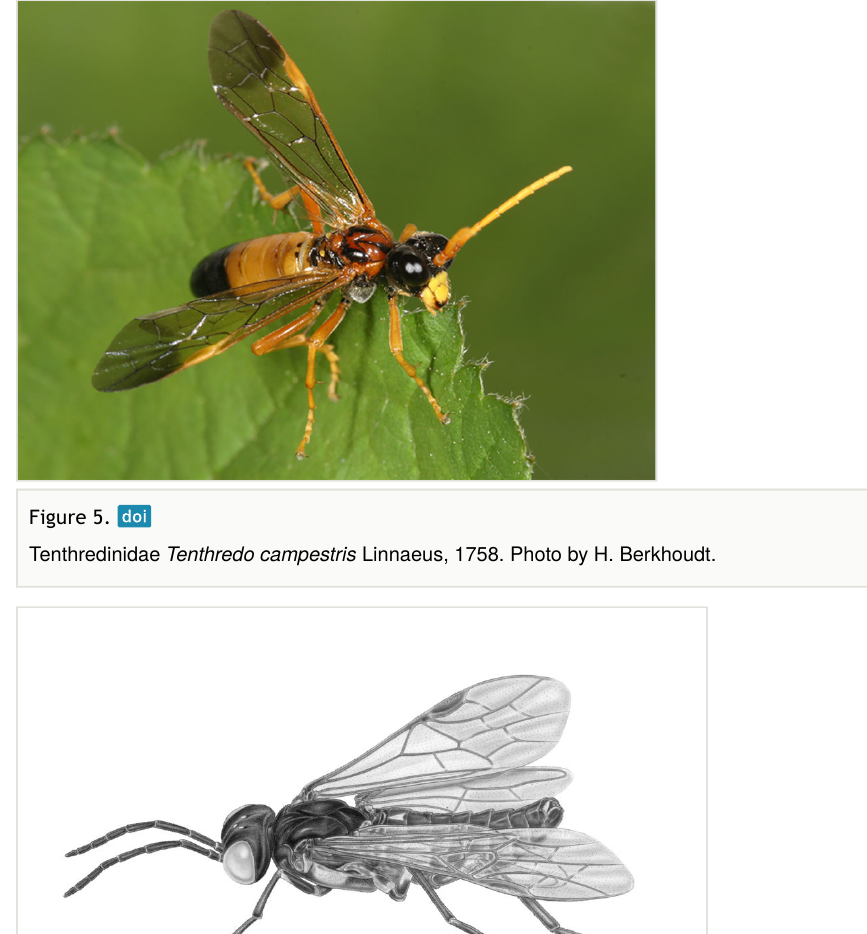
Heptamelidae: Small Old World family with only two genera and 36 extant species. The European Heptamelus species use ferns as their larval food: the egg is entirely inserted in the rachis or petiole of the fern and the larva bores in the petiole of fern. Previously treated as a tribe of Tenthredinidae-Selandriinae, but raised to family rank by Malm & Nyman (Malm and Nyman 2014). Larva of Pseudoheptamelus is exophytic. Cimbicidae: Rather small Holarctic family. The often conspicuous larvae live on various deciduous trees, climbers ( Lonicera spp.) and herbs (Fig. 7).